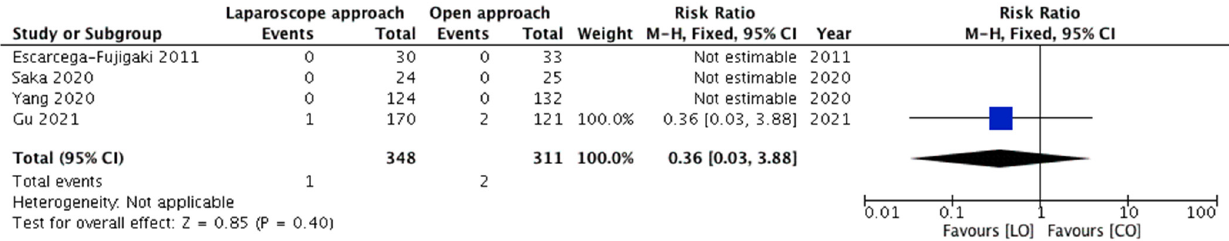
Figure 6. Forest plot comparison between the two treatment groups for the incidence of early postoperative complications after excluding the children with peeping testes.